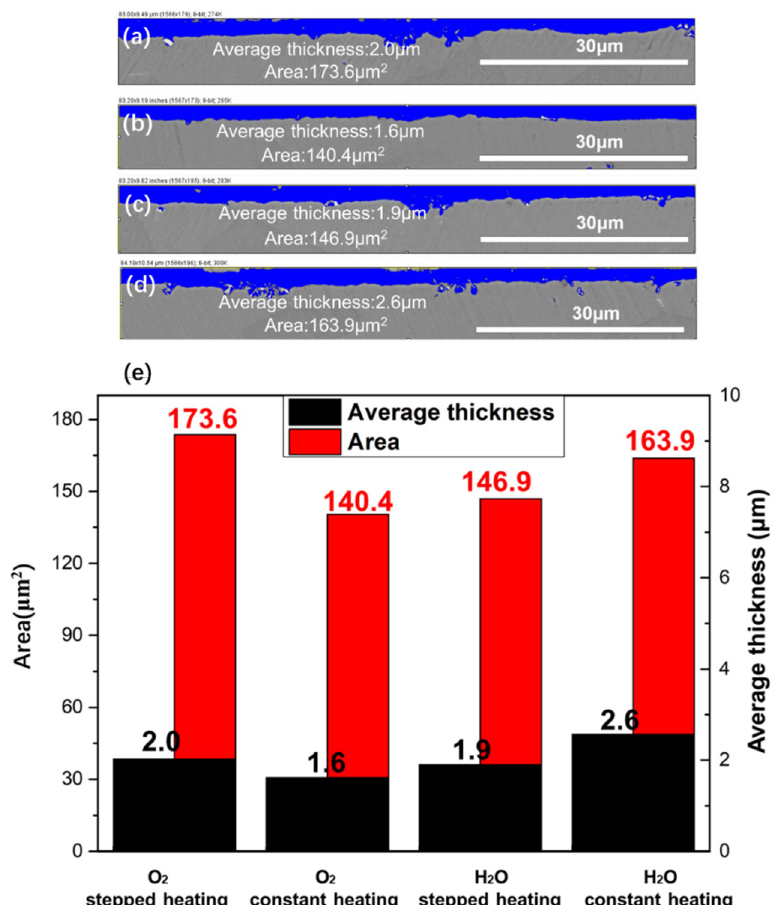
Figure 8. The average thickness and area of the oxide scale formed on the NiCrAlHf bond coat alloy after being oxidized at 1100 ◦ C for 24 h in different atmospheres and using different heating methods: ( a ) in air and stepped heating conditions; ( b ) in air and constant heating conditions; ( c ) in water vapor and stepped heating conditions; ( d ) in water vapor and constant heating conditions; ( e ) a histogram of the